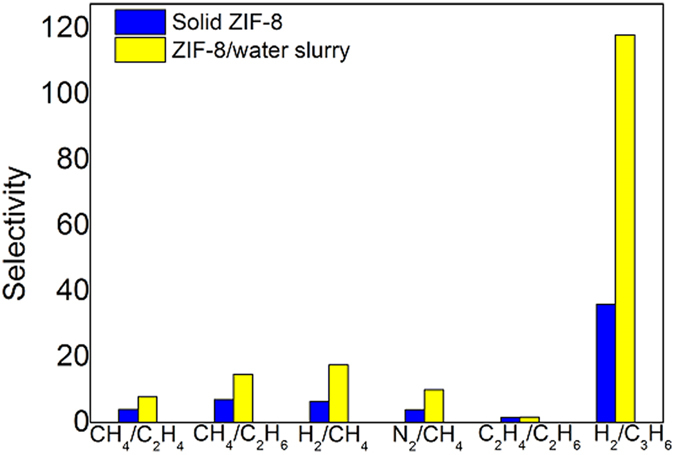
Comparison of the separation selectivity of solid ZIF-8 and ZIF-8/water slurry for CH4/C2H4, CH4/C2H6, H2/CH4, N2/CH4, C2H4/C2H6, and H2/C3H6 binary gas mixtures.